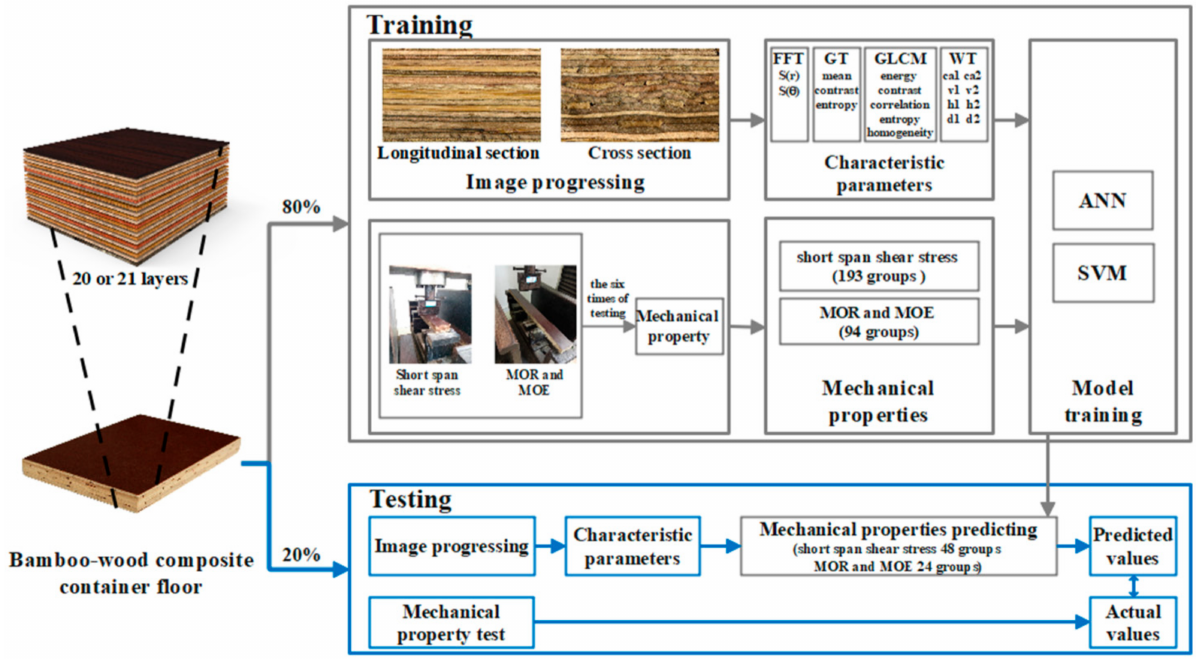
Figure 1. Flow chart of the